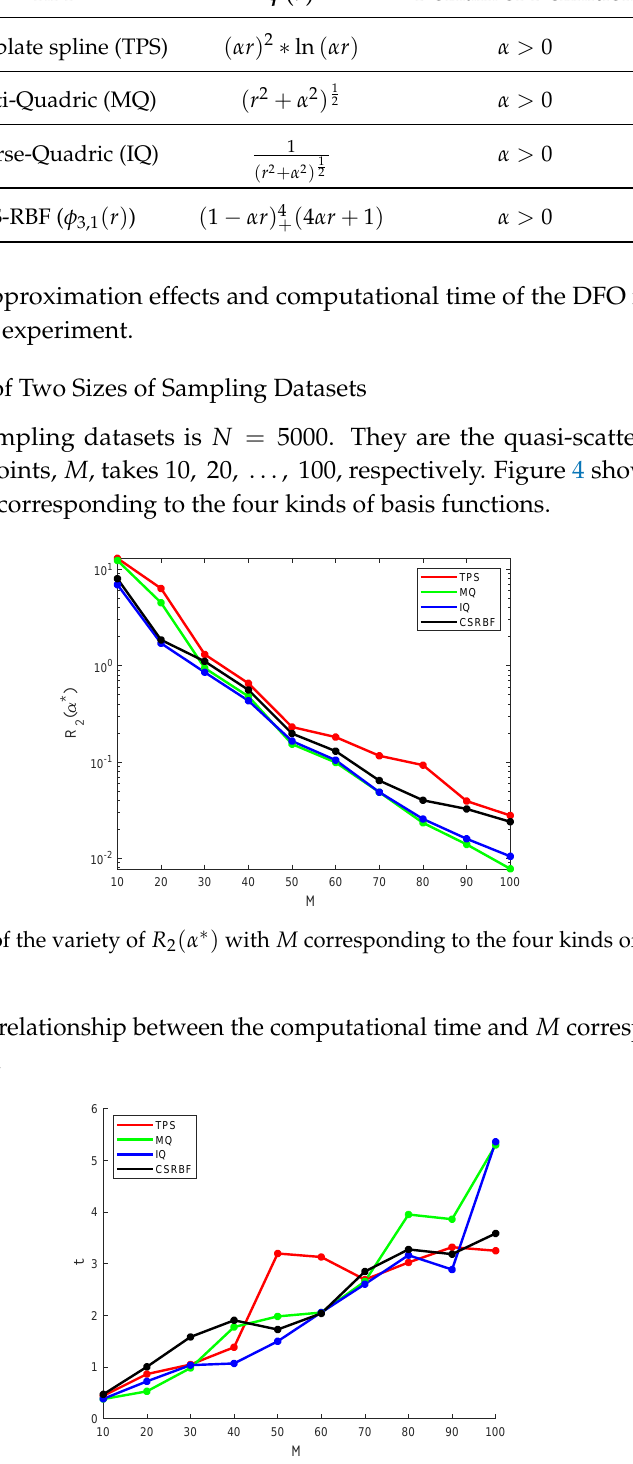
Figure 5. The graph of the variety of computational time with M corresponding to the four kinds of functions under N =